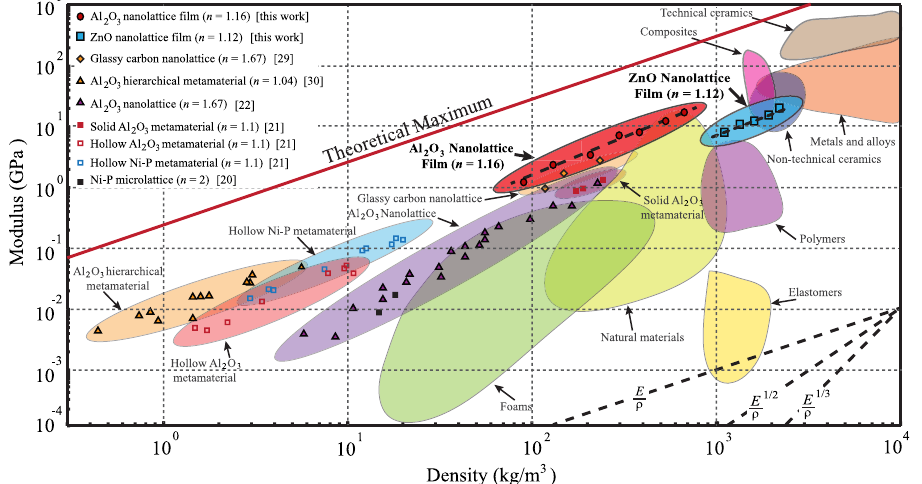
Figure 3. Modulus-density Ashby Chart. The indentation moduli of Al 2 O 3 and ZnO nanolattice are plotted against density for all the tested samples on an Ashby chart. The results for both ALD materials follow power law with scaling n ~